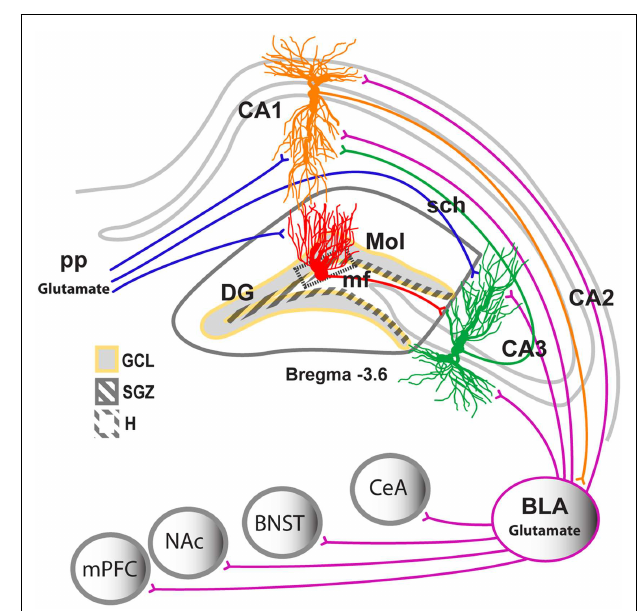
FIGURE 2 | Neuronal projections in the hippocampus . Schematic representation of the coronal view of the hippocampus region indicating the subregions of the hippocampus and their location within the hippocampus. CA, cornu ammonis;Trisynaptic circuitry in the hippocampus is indicated with axons from the entorhinal cortex projecting unidirectionally to the apical dendrites of the hippocampal DG, CA1, and CA3 neurons (perforant path projection). DG neurons project to the apical dendrites of the CA3 pyramidal neurons (mossy fiber projection). CA3 neurons project to the apical dendrites of the CA1 neurons (Schaffer collateral projection). The CA1 neurons have bidirectional projections to and from the BLA.The BLA also sends projections to the medial prefrontal cortex (mPFC), nucleus accumbens (NAc), bed nucleus of the stria terminalis (BNST), and central nucleus of the